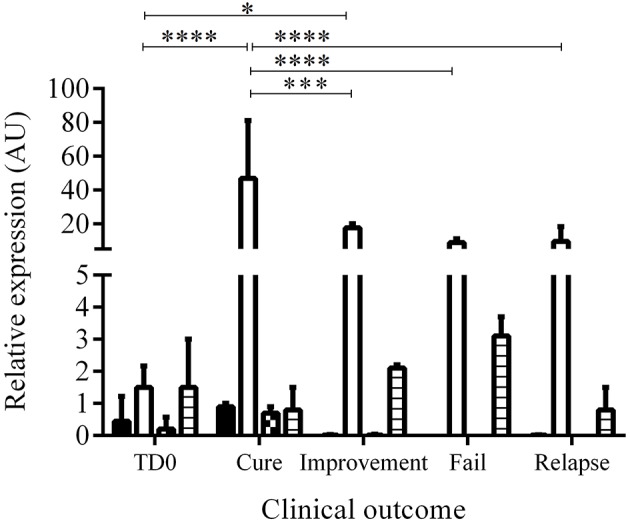
Relative expression of growth factors before and during treatment. The figure shows the induction of growth factors calculated by the ΔΔCT between TD0 and TD7 method according to the clinical outcome. Bars represent the mean value ± SD. PDGF (black), EGF (white), FGF (square), and TGFβ1 (lines). *p < 0.0413; ***p < 0,0003; ****p < 0.0001, cured (n = 10), improvement (n = 24), fail (n = 27), relapse (n = 3).